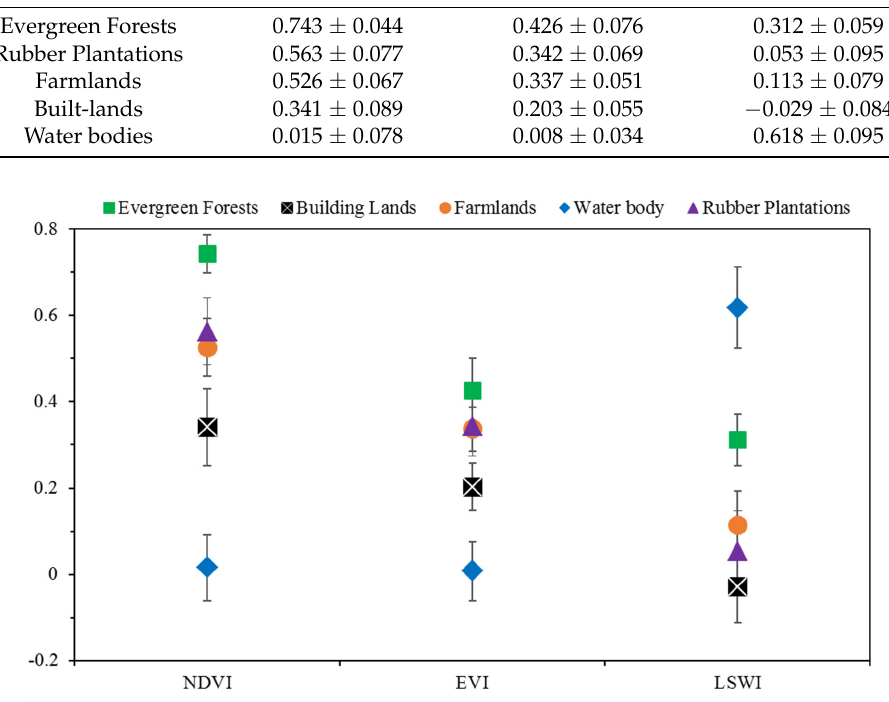
Figure 4. Signature analysis of the Normalized Difference Vegetation Index (NDVI), Enhanced Vegetation Index (EVI), and Land Surface Water Index (LSWI) for tropical evergreen forests, rubber plantations, farmlands, built-lands, and water bodies based on the Landsat Thematic Mapper (TM) 5 images between Julian Dates 20 and 120 in 2010 in the study area. Evergreen forests and other land cover types have distinctive values in NDVI and LSWI.